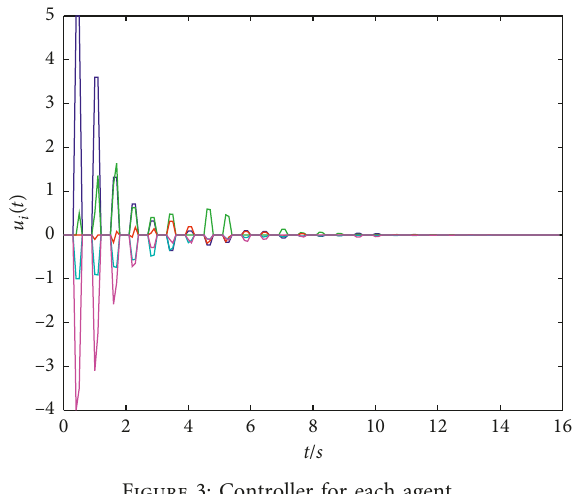
Figure 3: Controller for each